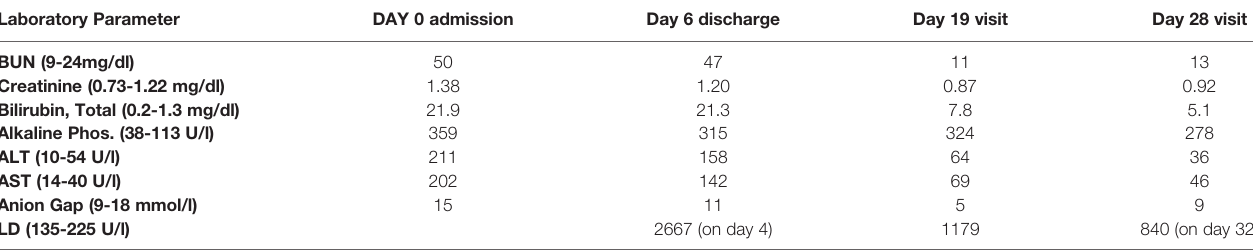
TABLE 1 | Patient laboratory values pre-treatment at admission (day 0) and post-treatment on day 6, 19, and 28. Laboratory